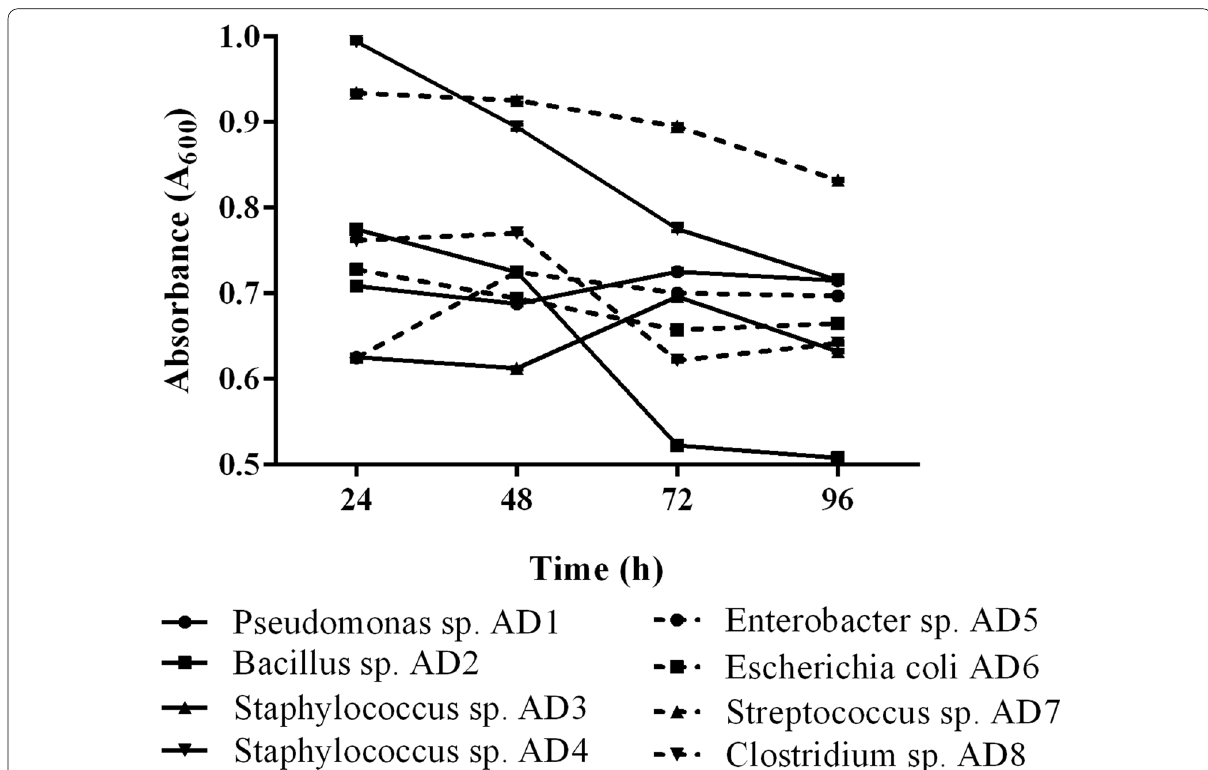
Fig. 2 Dye decolourization assay using selective bacterial isolates by UV–Vis